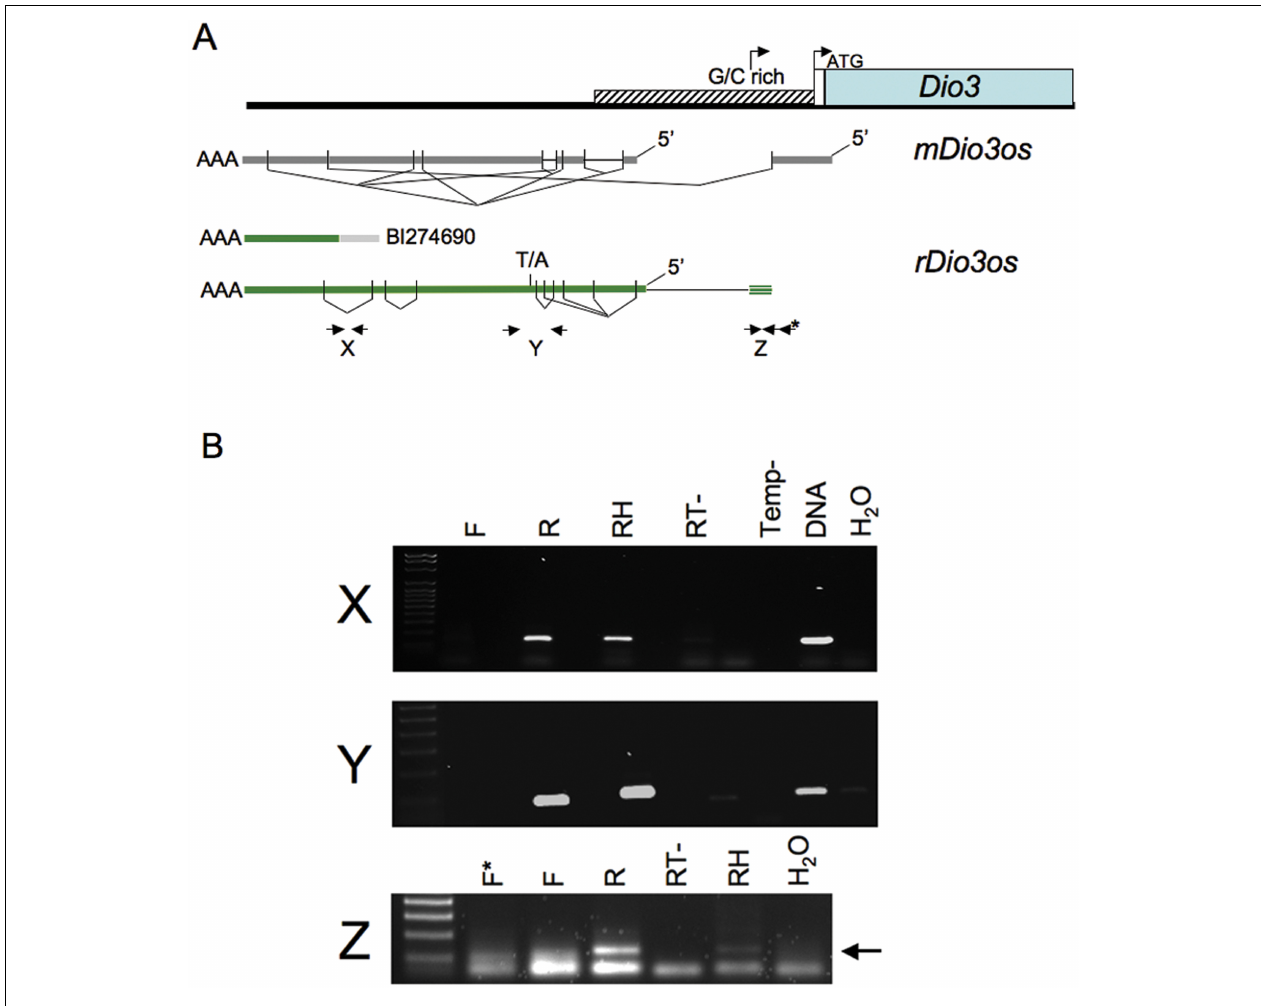
RT-PCR of adult male rat hippocampal (X,Y) or placental (Z) total RNA using primers specific for opposite strand expression (reverse primer: R) or sense expression (forward primer: F) across the rDio3 upstream region shows expression is derived exclusively from the opposite strand. Controls: Positive : Random hexamer-primed RT-PCR (RH), which will copy potential transcripts from either strand; genomic DNA (DNA). Negative : Reverse transcriptase deficient (RT − ) or template deficient (Temp − ) RT-PCR reactions; template-deficient (H 2 O) PCR